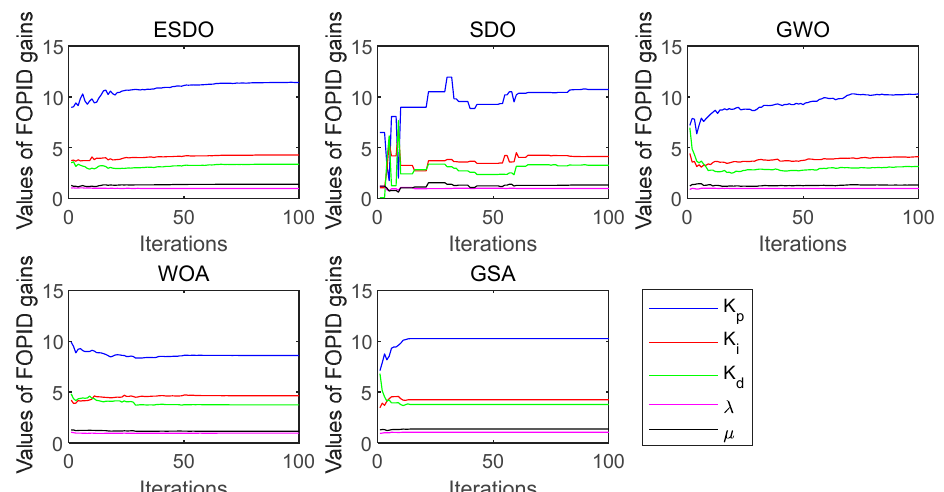
Figure 13. Convergence curves of FOPID parameters with 8% load.